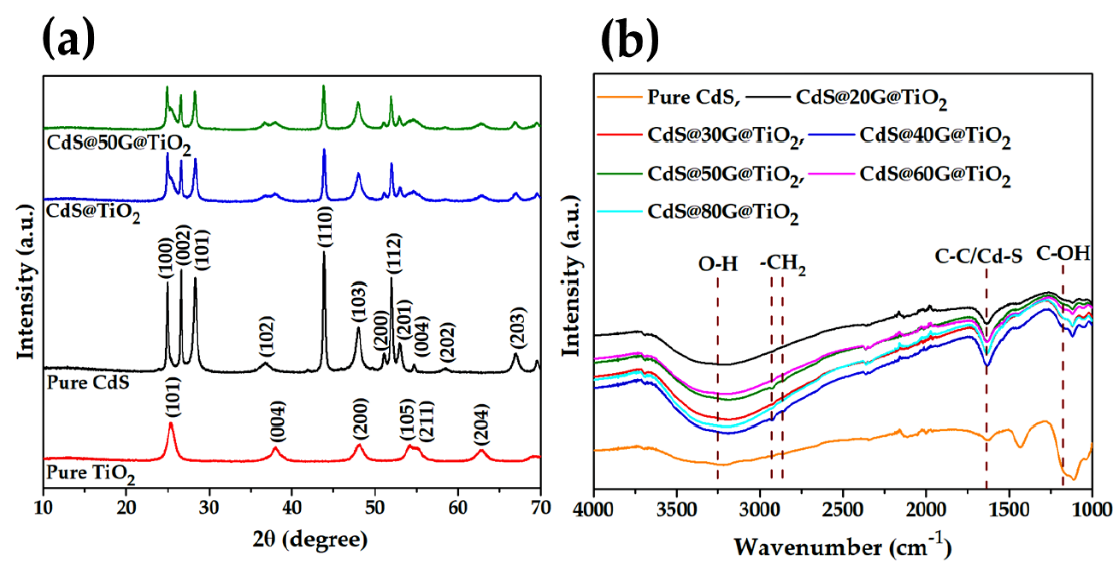
Figure 1. ( a ) XRD patterns of pure TiO 2 , CdS and CdS@XG@TiO 2 samples and ( b ) FTIR spectra of pure CdS and CdS@XG@TiO 2 samples.